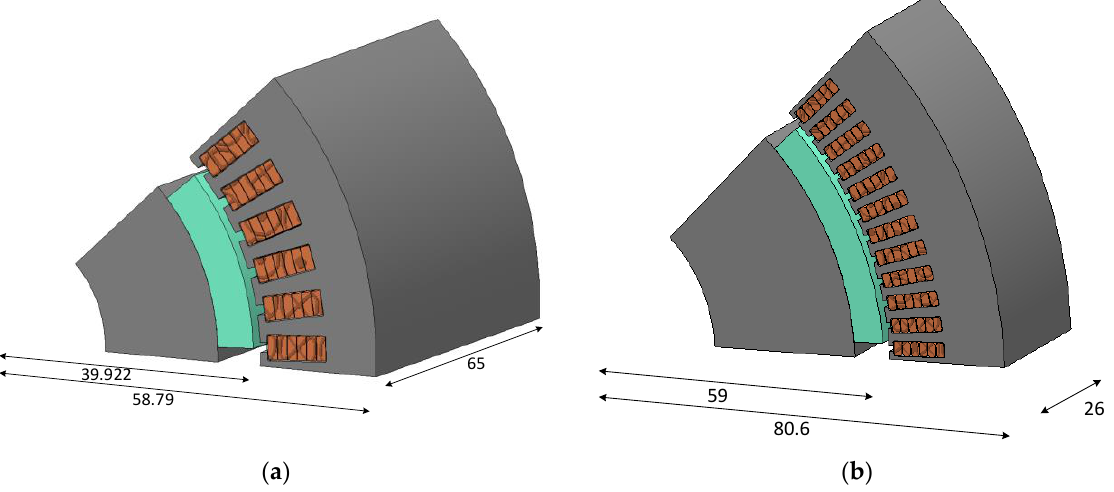
Figure 9. the final Pareto front with the final optimum point.